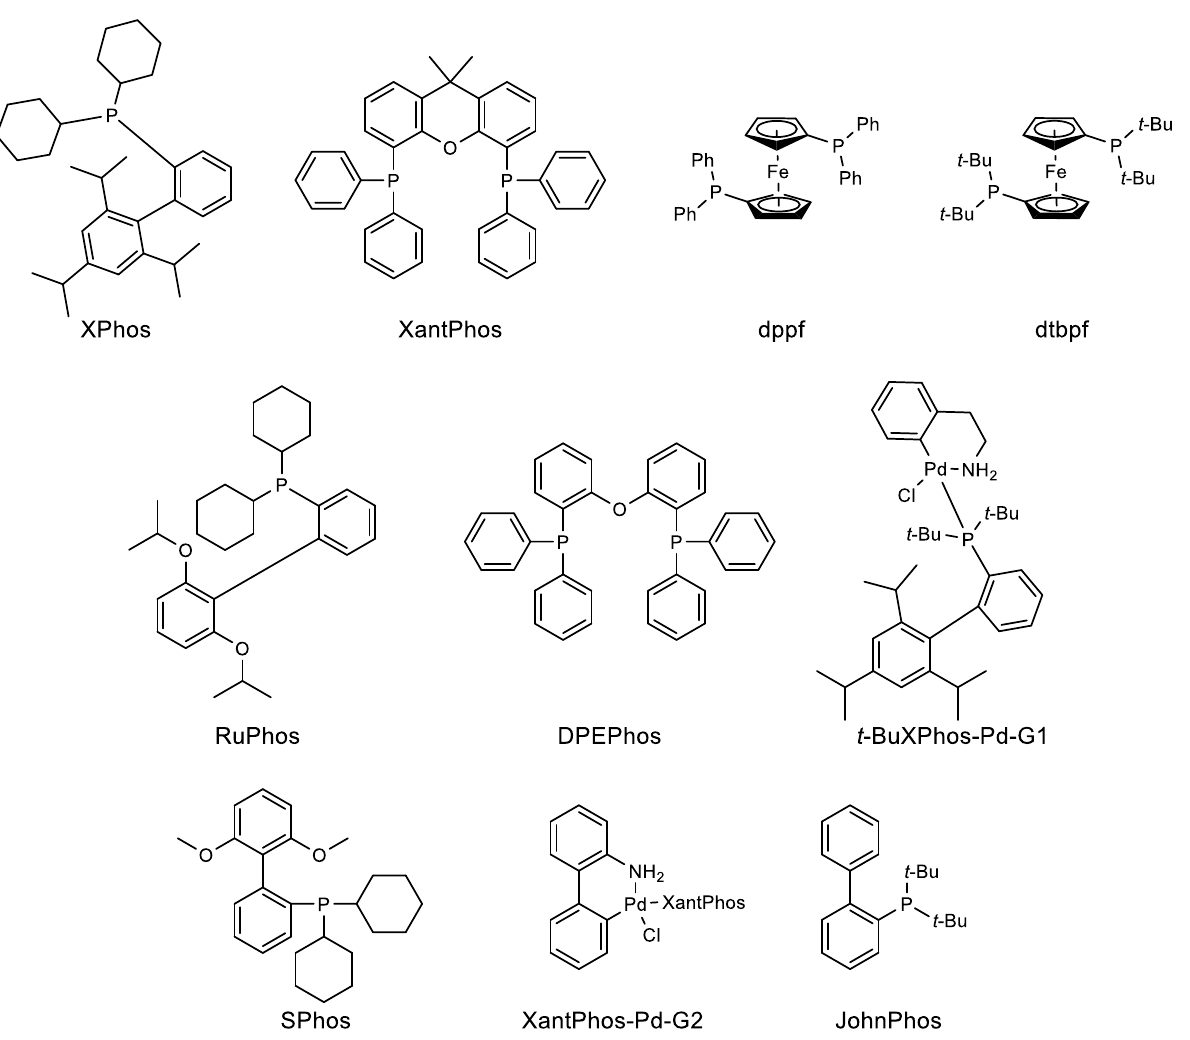
Figure 1. Structures of ligand and catalysts used in this review.